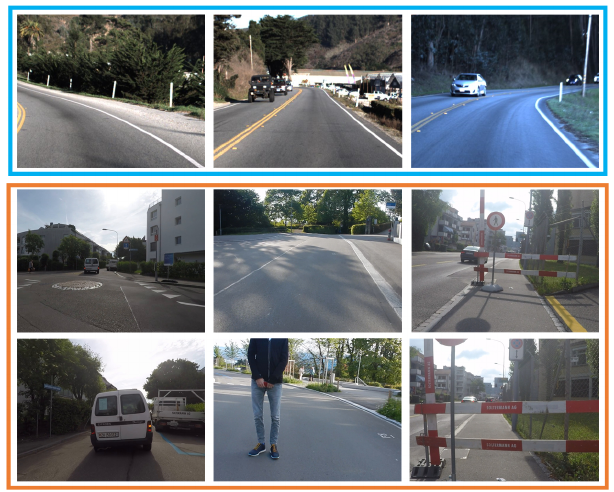
Figure 2. The sky blue box contains Udacity images which uses to learn and control steering angles, the orange box includes no-collision and corresponding collision frames which are collected to predict the probability of